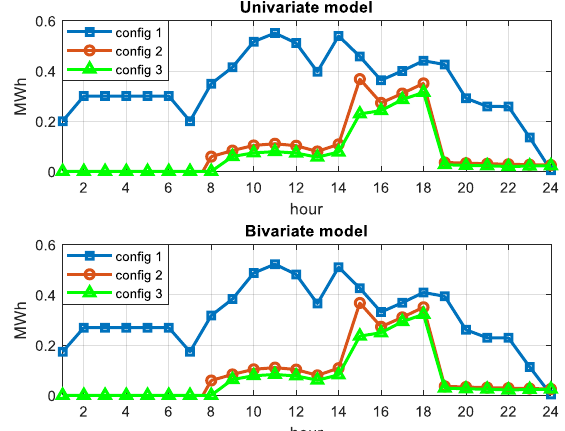
Figure 11. EENS under different system configurations calculated using univariate and bivariate wind prediction models.